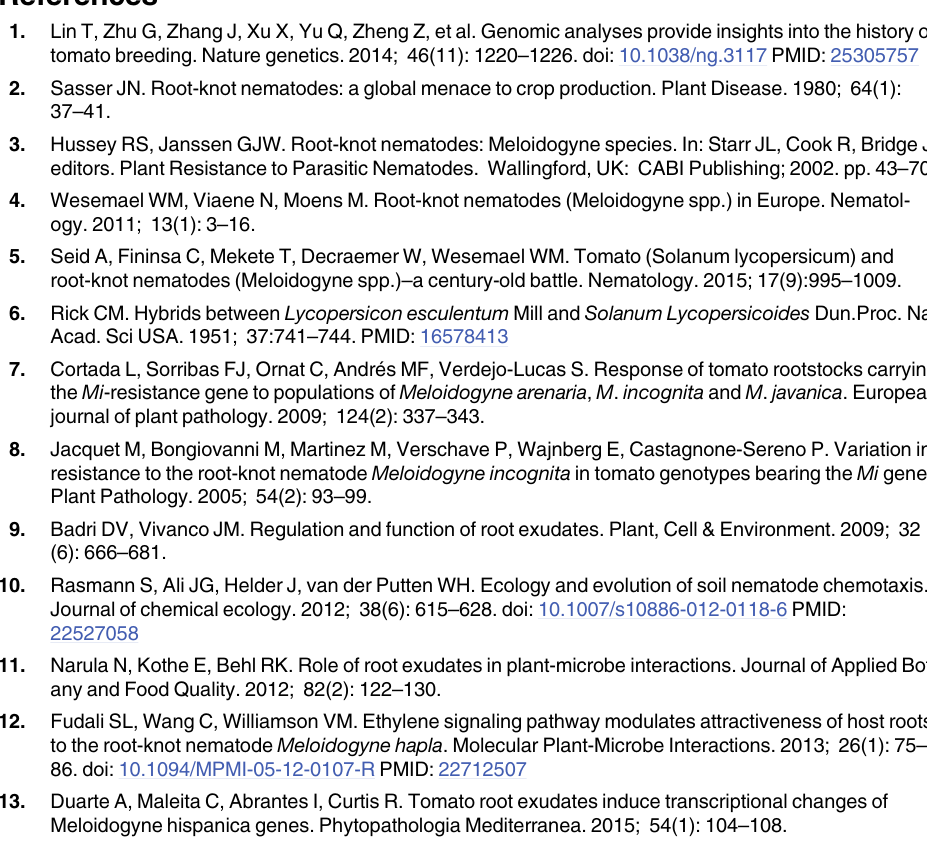
S2 Table. Effects of simulated components on corrected mortality of M . incognita J2 at 24 and 48 h. a A, 2,6-Di-tert-butyl-p-cresol; B, L-ascorbyl-2,6-dipalmitate; C, dibutyl phthalate; D, dimethyl phthalate; 0.5,0.5 mmol (cid:1) L -1 ; 1,1 mmol (cid:1) L -1 ; 2,2 mmol (cid:1) L -1 . b Capital and lower case letters indicate significant group differences at the levels of 0.01 and 0.05, respectively. S3 Table. Effects of simulated components on disease resistance to M . incognita in cv. L- 402. a A, 2,6-Di-tert-butyl-p-cresol; B, L-ascorbyl-2,6-dipalmitate; C, dibutyl phthalate; D, dimethyl phthalate; 0.5,0.5 mmol (cid:1) L -1 ; 1,1 mmol (cid:1) L -1 ; 2,2 mmol (cid:1) L -1 ; CK: 1.0% ethanol. b Capital and lower case letters indicate significant group differences at the levels of 0.01 and 0.05,